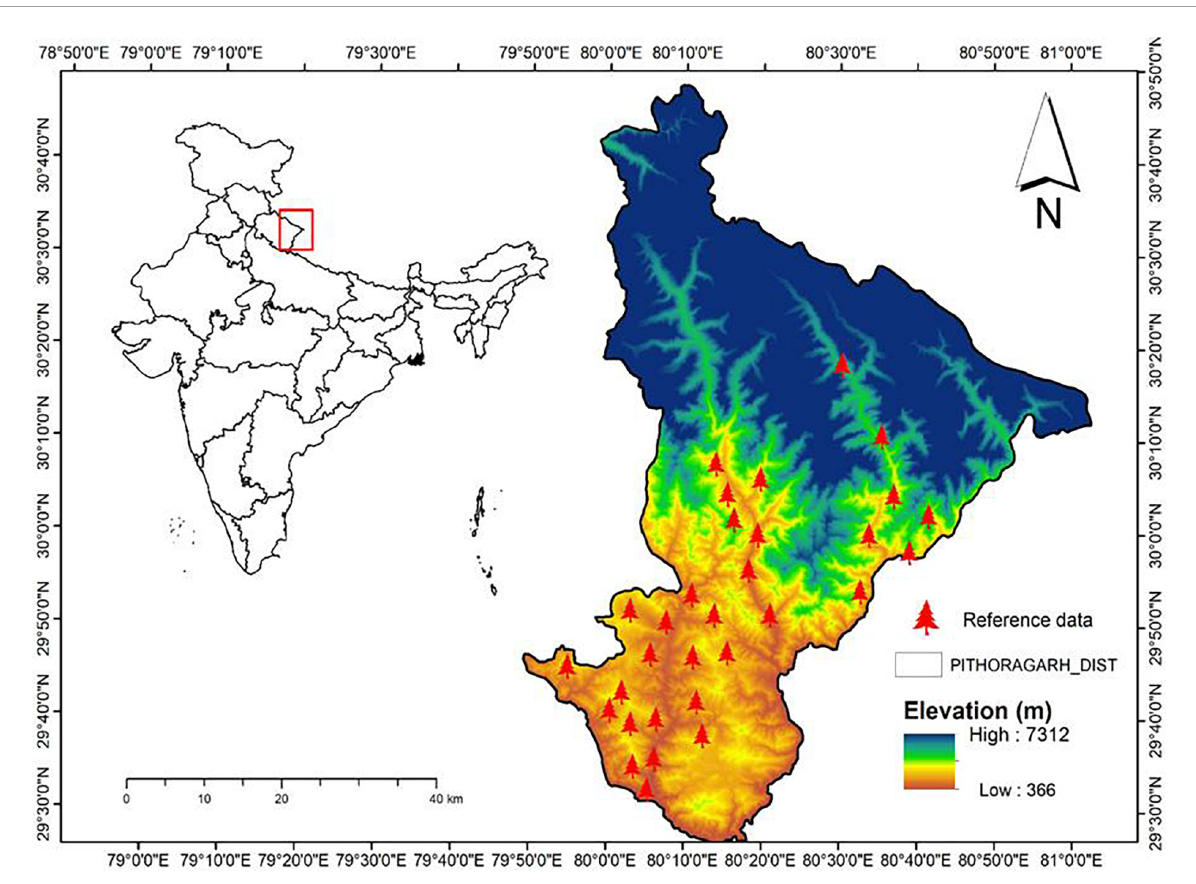
FIGURE1 Study area map with sites locations. Scale in the map represents the study